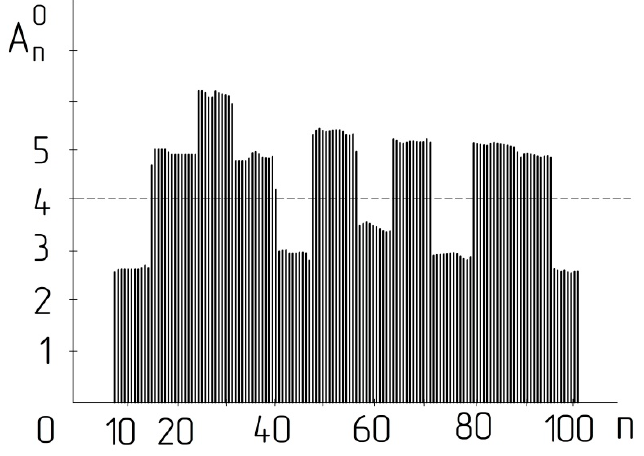
Figure 11. The rotor system spectrum with the triangular modulation function and the number of places m = 1528.